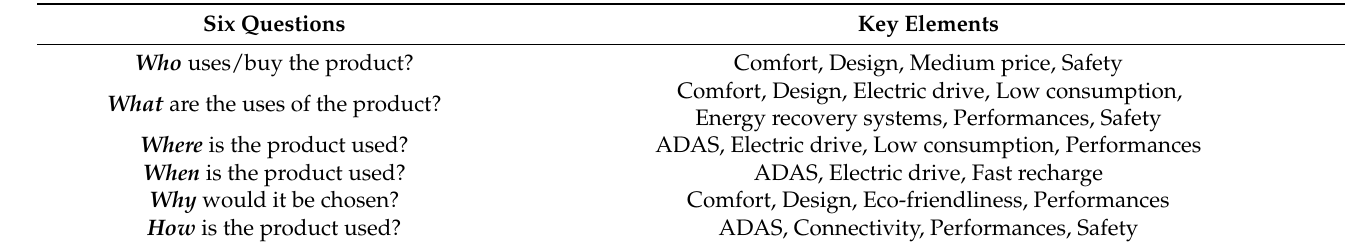
Table 1. QFD—six questions and identification of key customer requirements.